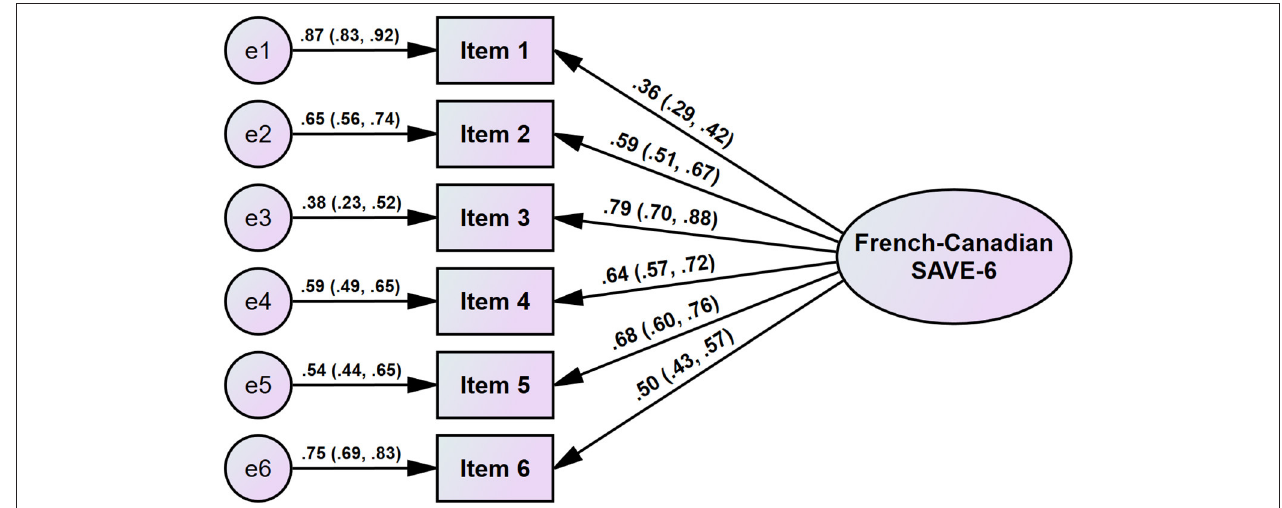
FIGURE 1 | Factor structure of the French–Canadian version of the SAVE-6